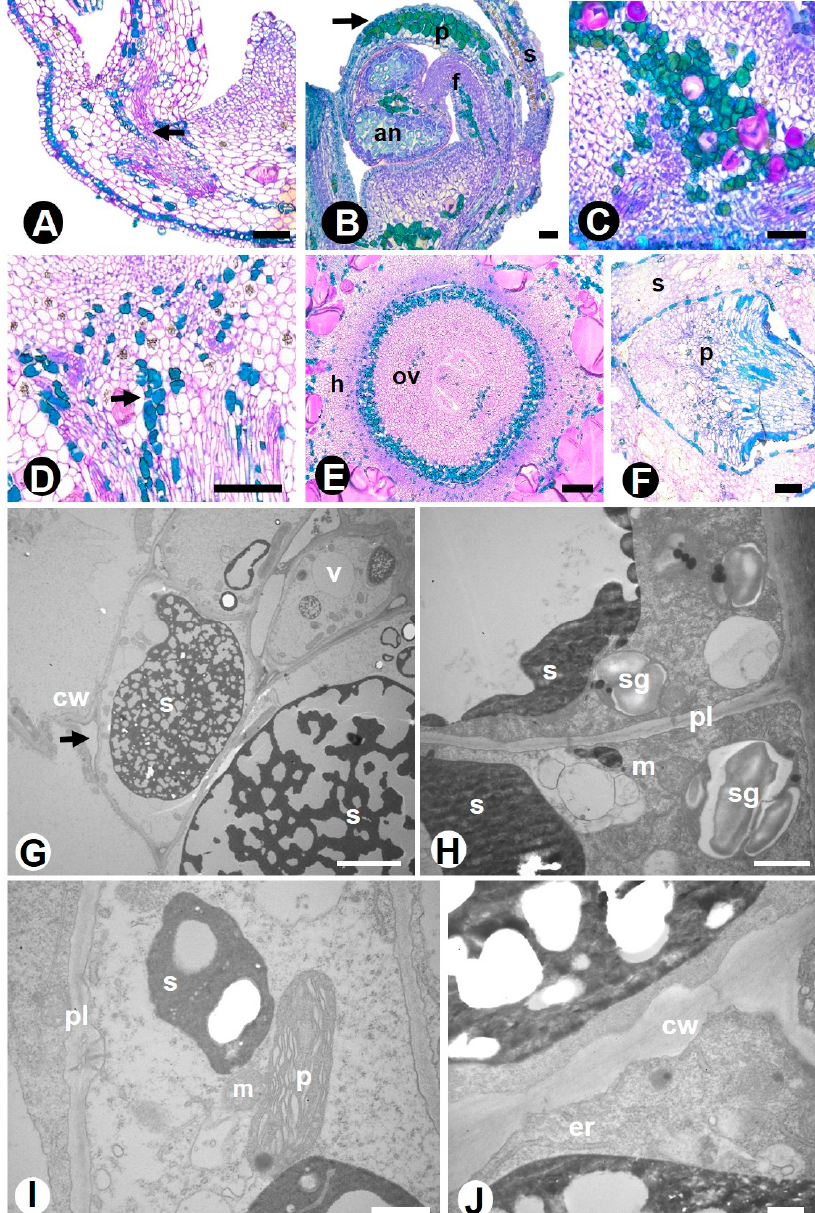
Figure 3. Phenolic idioblasts in the flower of Rhamnaceae species. ( A – F ) = LM, ( G – J ) = TEM. ( A – D ) = longitudinal sections, ( E , F ) = transverse sections. ( A ) Colubrina glandulosa —phenolic idioblasts (arrow) in the organs of the perianth, forming a subepidermal row in the hypanthium base. ( B ) Gouania virgata —phenolic idioblasts (arrow) forming clusters in the petal mesophyll, anther connective, and hypanthium parenchyma. ( C ) Gouania latifolia —phenolic idioblasts in the hypanthium parenchyma (floral cup base). ( D ) Hovenia dulcis —clustered phenolic idioblasts (arrow) in the hypanthium parenchyma, below the carpel and nectary. ( E ) Rhamnidium elaeocarpum —phenolic idioblasts surrounding the base of the ovary; note the idioblasts scattered in the hypanthium. ( F ) Sarcomphalus joazeiro —phenolic idioblasts in the sepal and petal parenchyma. ( G – H ) H. dulcis —phenolic idioblast with secretion in the central vacuole and several plastids with starch grains in the parietal cytoplasm. ( I – J ) R. elaeocarpum —cytoplasm with plastids, mitochondria, and vacuole with electron-dense secretion. Symbols: an = anther, cw = cell wall, er = endoplasmic reticulum, f = filament, h = hypanthium, m = mitochondria, ov = ovary, p = petal (LM), p = plastid (TEM), pl = plasmodesma, s = sepal (LM), s = secretion (TEM), sg = starch grain, v = vacuole. Scale bars: ( A , B ), 50 µ m; ( C – F ), 100 µ m; ( G ), 10 µ m; ( H – J ), 2 µ